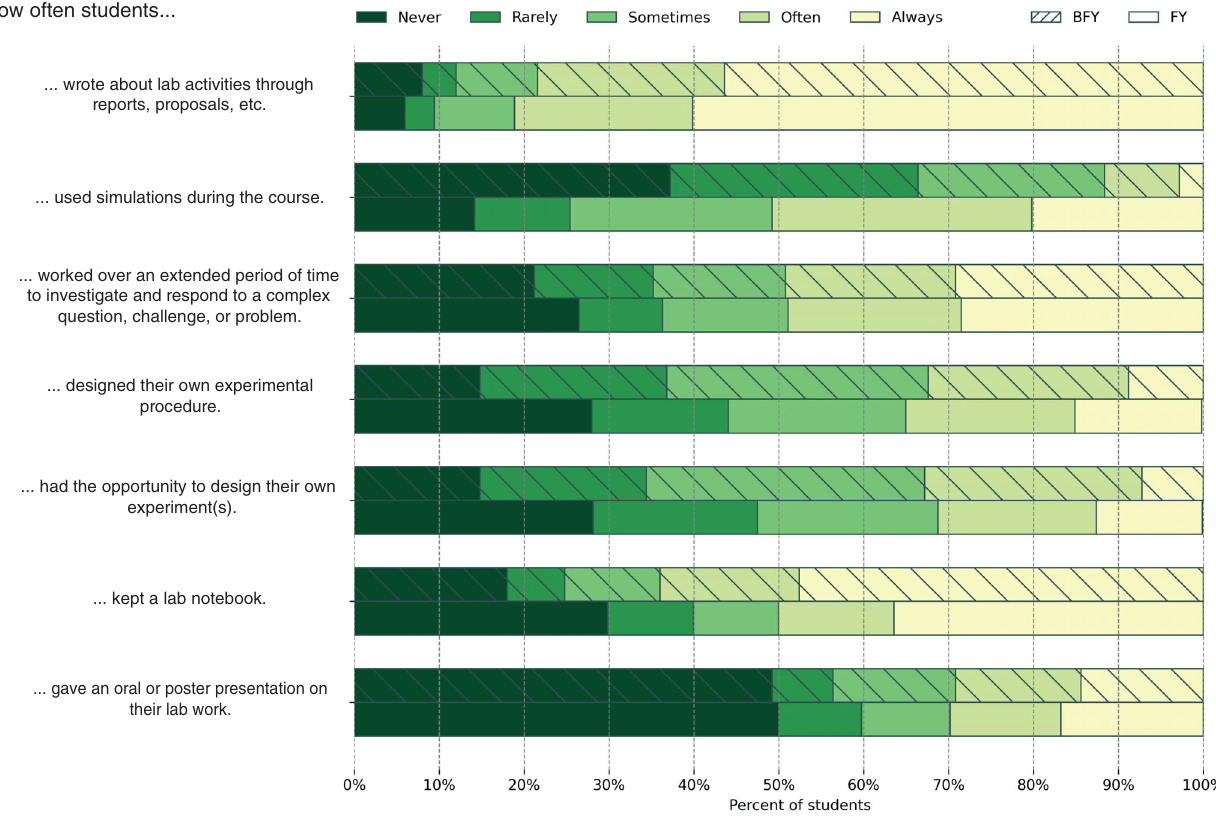
FIG. 3. Percent of students in FY (plain, N ¼ 4565 ) and BFY (hatched, N ¼ 250 ) courses who never, rarely, sometimes, often, and always (progressively lighter shades of green) performed different activities in their lab course. These activities are ordered by the percent of FY students who responded